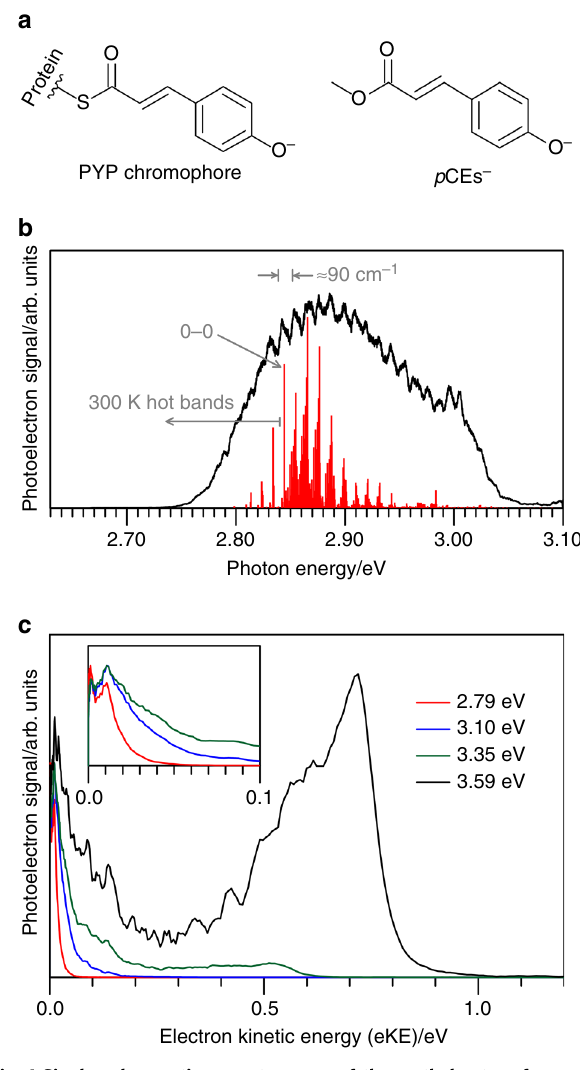
Fig. 1 Single-colour action spectroscopy of the methyl ester of deprotonated para -coumaric acid ( p CEs − ). a Structure of the photoactive yellow protein (PYP) chromophore and the E -isomer of p CEs − . b Photodetachment action spectrum of p CEs − (black) and Franck-Condon- Herzberg-Teller simulation of the S 1 ( ππ *) ← S 0 transition at 300 K (red). c Photoelectron spectra of p CEs − using hv = 2.79 (red), 3.10 (blue), 3.35 (green), and 3.59 eV (black). The inset in c shows the low-eKE